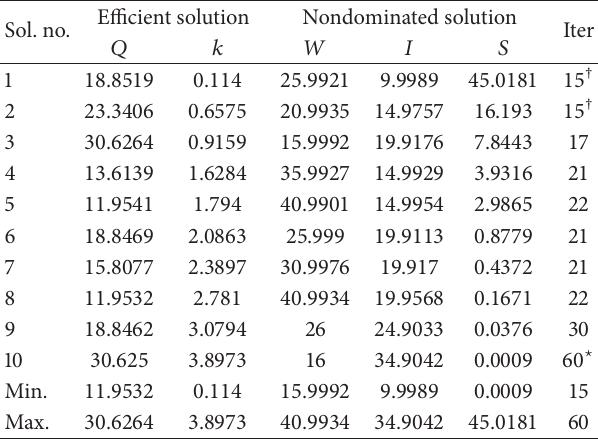
Table 3: Tradeoff solutions of Item 2 generated by successive approximation.